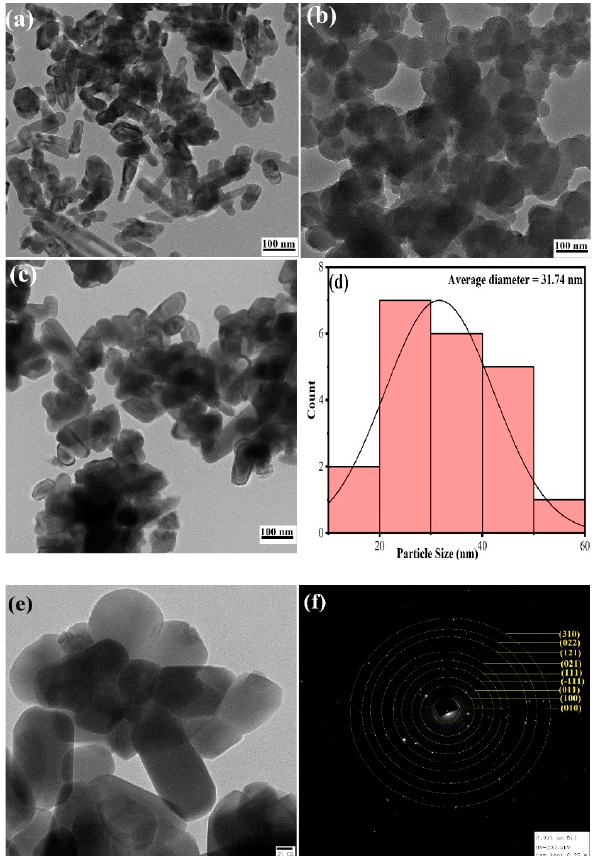
Figure 4. TEM images of ( a ) ZnWO 4 ; ( b ) CoWO 4 ; ( c ) Zn 0.5 Co 0.5 WO 4 at 100 nm magnification range; ( d ) particle size histogram; ( e ) TEM image of Zn 0.5 Co 0.5 WO 4 at 20 nm magnification range; ( f ) selected area electron diffraction (SAED) image of Zn 0.5 Co 0.5 WO 4.